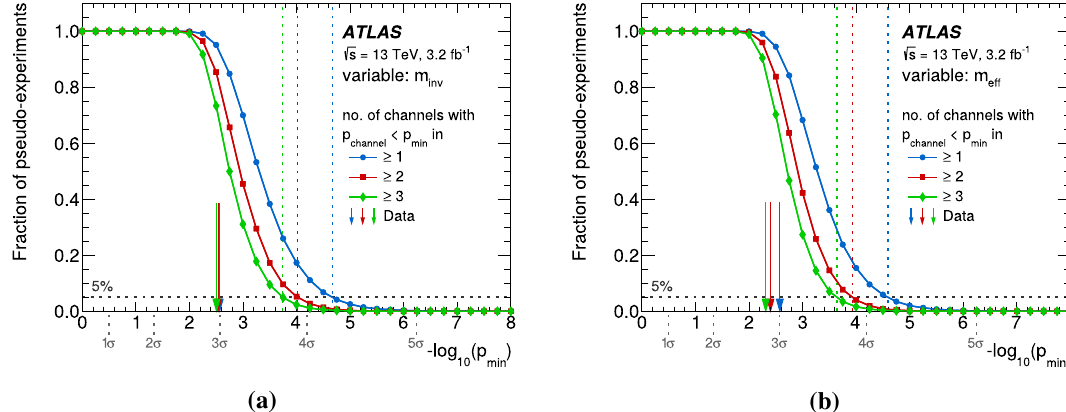
Fig. 10 The fractions of pseudo-experiments ( P exp , i ( p min ) ) which have at least one, two or three p channel -values (circular, square, and rhombic markers respectively) smaller than a given threshold ( p min ) in the scans of a the m inv distributions, and of b the m eff distributions. The